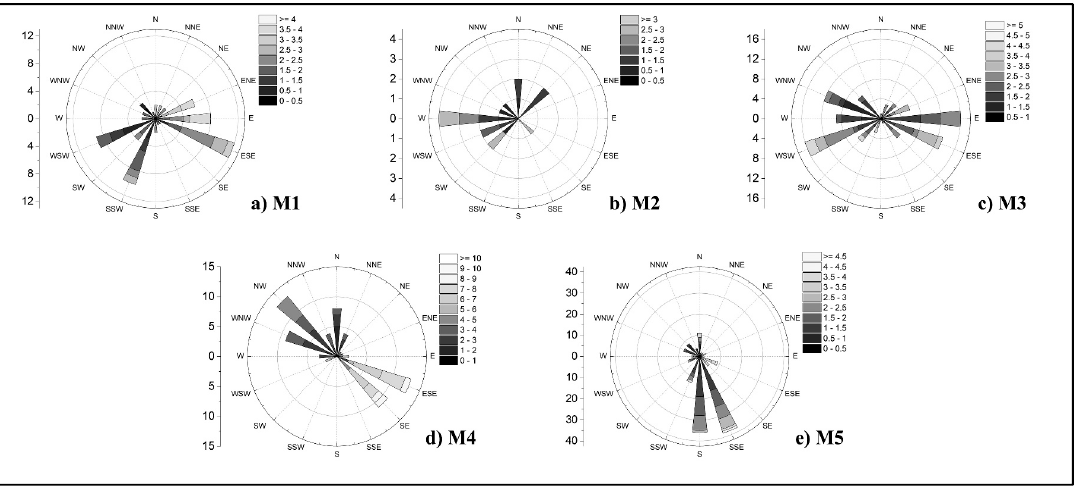
Figure 2. Pollution wind roses at each monitoring stations.